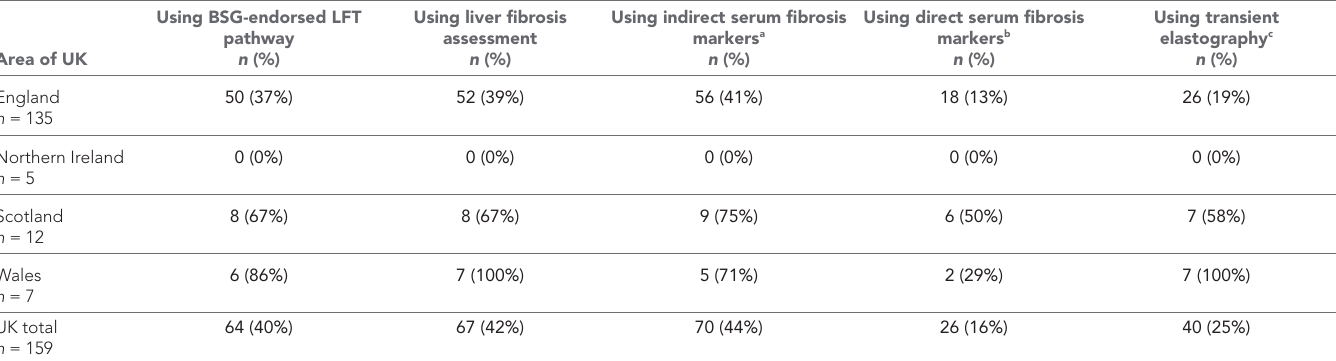
Table 2 The recommended management of liver disease in UK clinical commissioning groups and health authorities in relation to national standards and